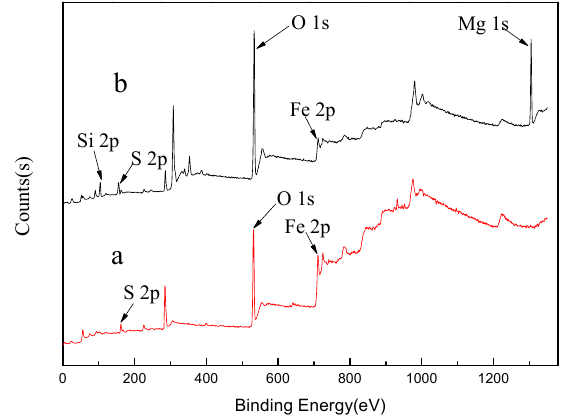
Figure 4. Broad scan X-ray photoelectron spectroscopy (XPS) spectra for: ( a ) pyrrhotite and ( b ) mixed minerals (pyrrhotite/chlorite = 10:1) at a pH of 9 and a speed of 1500 rpm for 5 min.